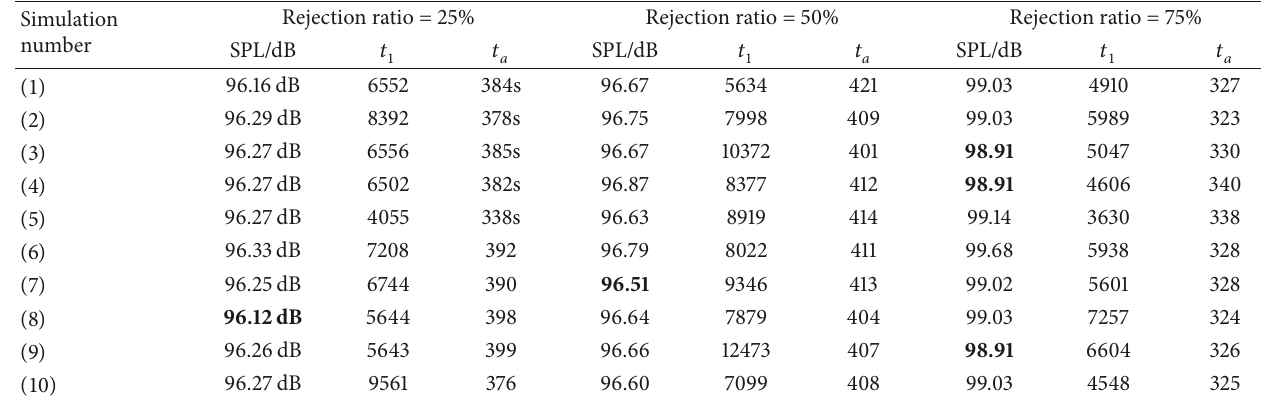
Table 4: Execution time in seconds using GA for first BC.